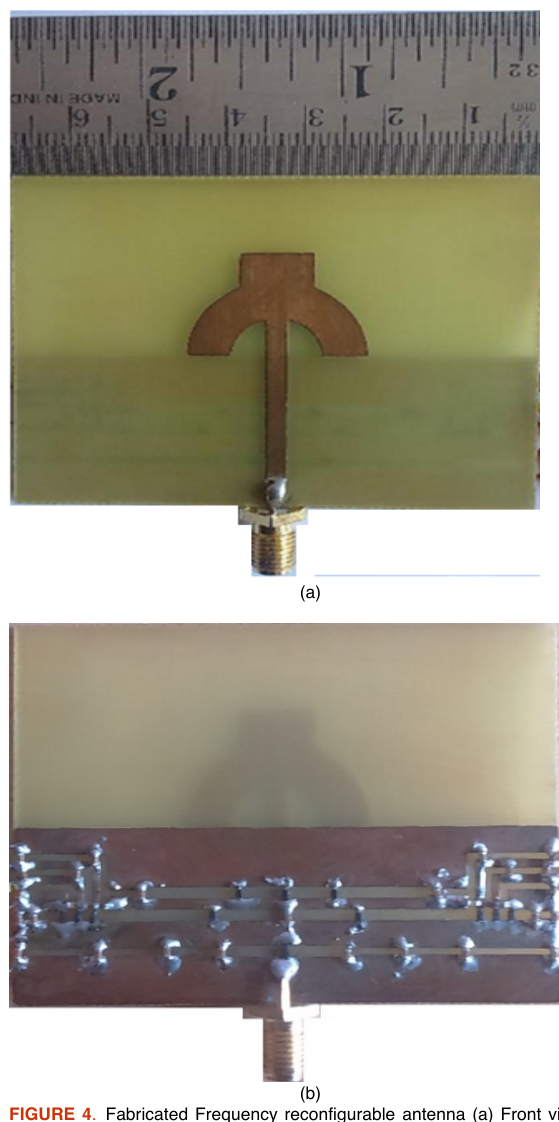
FIGURE 4 . Fabricated Frequency reconfigurable antenna (a) Front view (b) Back